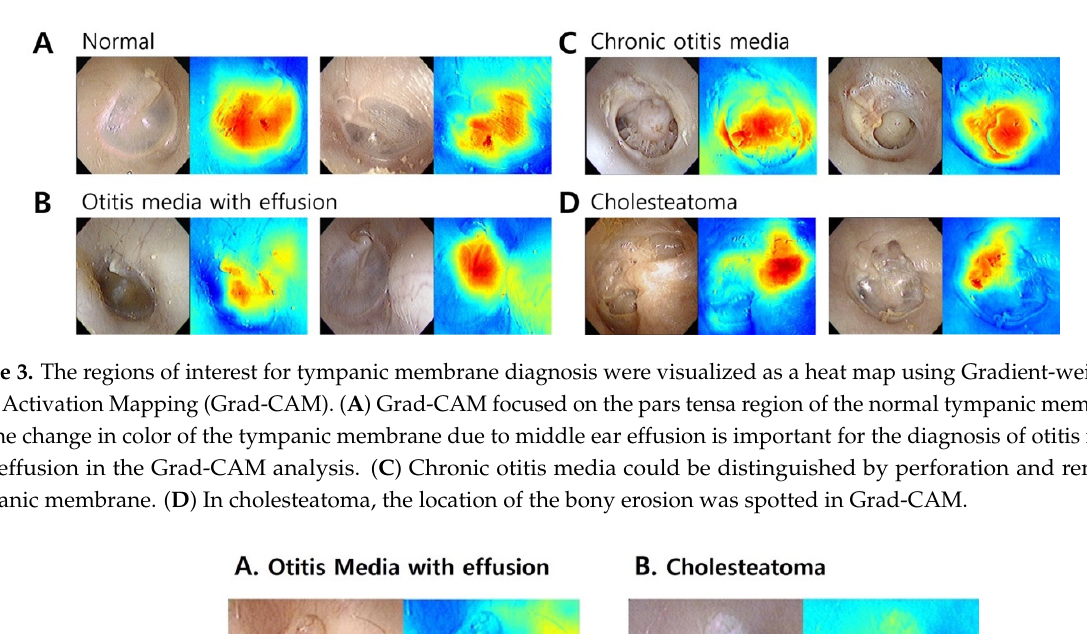
Figure 4. Gradient-weighted Class Activation Mapping (Grad-CAM) of the incorrectly predicted tympanic membrane images. ( A ) Otitis media with effusion was misdiagnosed as chronic otitis me- dia because the machine learning model focused on the retracted part of the tympanic membrane and considered it as a perforation. ( B ) The machine learning model predicted a normal tympanic membrane by focusing on the pars tensa area of the tympanic membrane. The heat map image failed to highlight the small attic retraction and cholesteatoma materials.